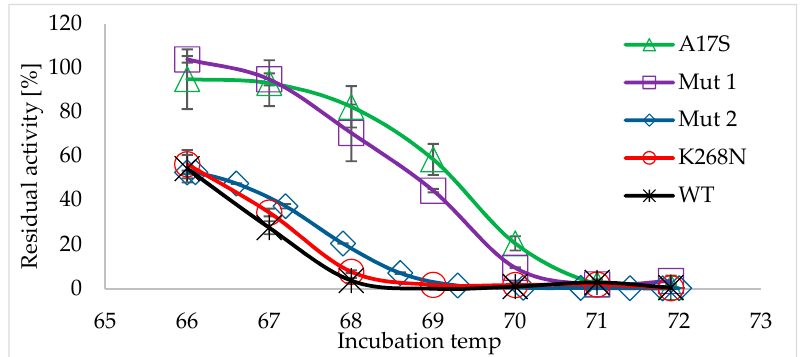
Figure 1. Thermostability of the various C. thermocellum BglA mutants. Wild-type (WT) C. thermocellum BglA and the di ff erent mutants were incubated at 66–72 ◦ C for 1 h, followed by activity assay (using p -nitrophenyl- β - d -1,4-glucopyranoside [ p NPG], an analogue of the natural β -glucosidase substrate). Residual activity of the di ff erent mutants (defined as the activity of the heat-shocked enzyme × 100 / activity of the non-heated enzyme) was calculated. Mut 1 and A17S demonstrated similar thermostability.